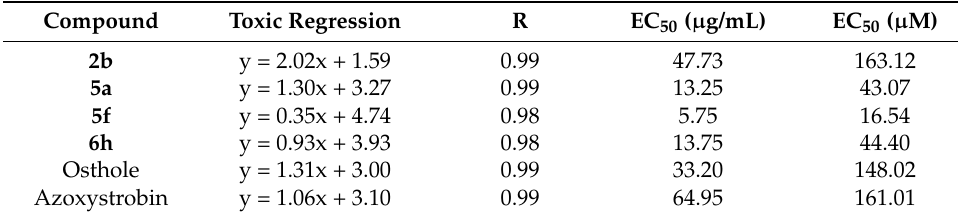
Table 3. EC 50 values determination of some target compounds against B. cinerea .